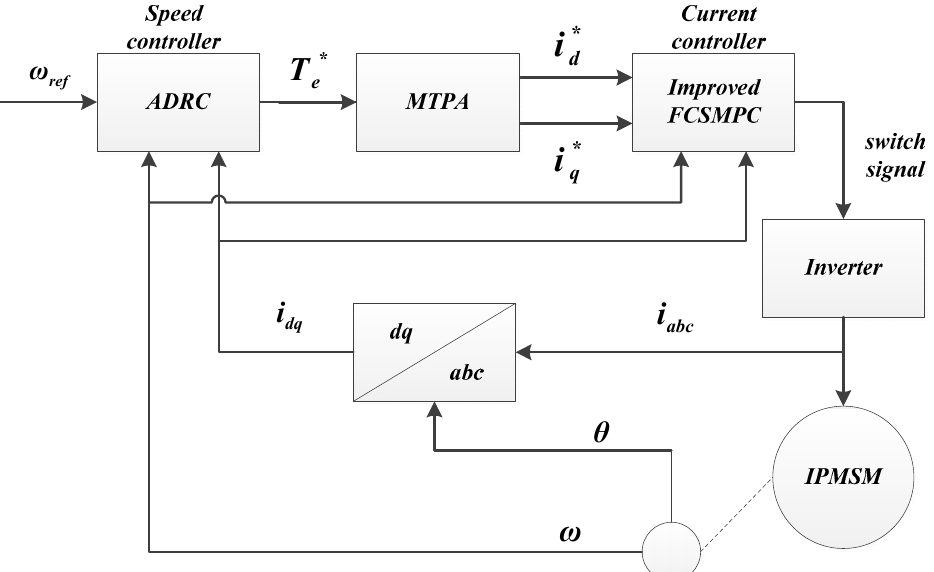
Figure 1. The block diagram of interior permanent magnet synchronous machines (IPMSM) cascade control strategy based on active disturbance rejection control (ADRC) and improved finite control set model predictive control (FCSMPC).